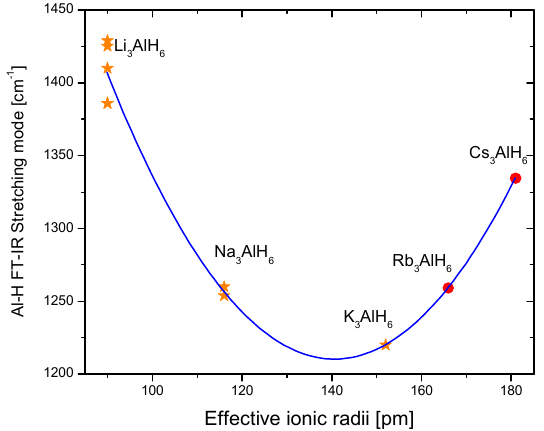
Figure 30. Most intense peak of infrared vibrations in the group 1 intermediaries, M 3 AlH 6 . The red dots are an extrapolation based on the fitted